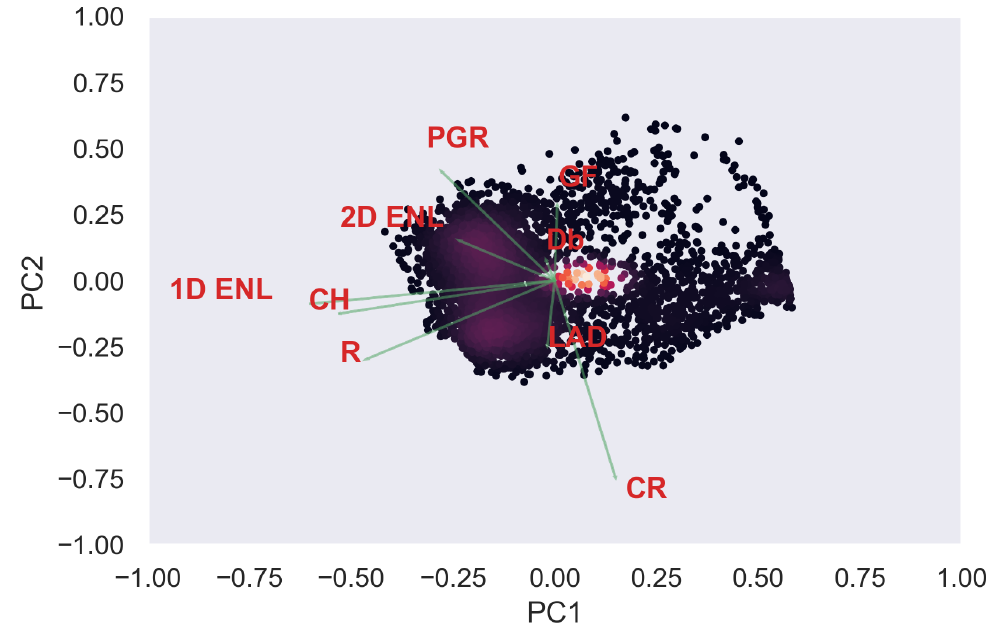
Figure A34. TLS PCA band 1 and 2 loadings at 1m grid